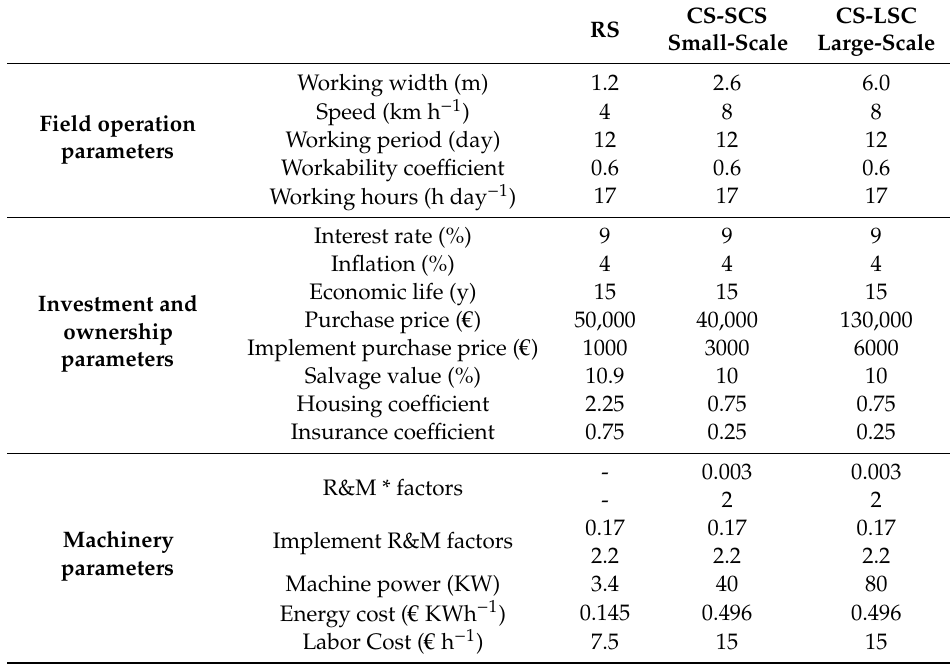
Table 1. Input parameters for the economic model (RS—Robotic System; CS—Conventional System; SCS—small-scale scenario; LSS—Large-scale